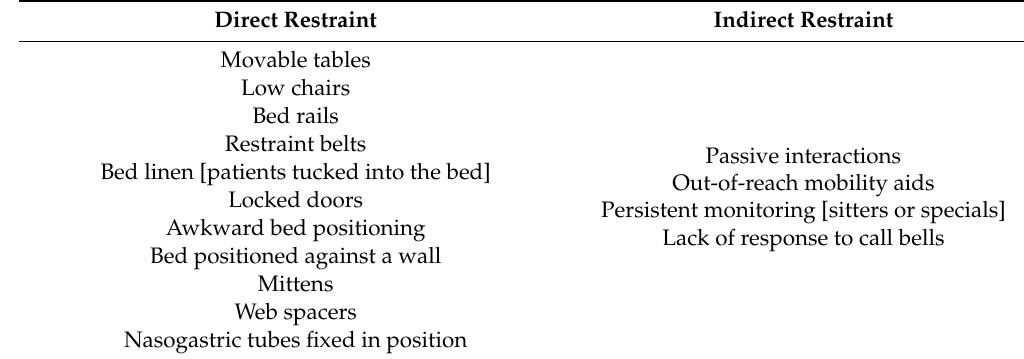
Table 1. Examples of direct and indirect restraint used in clinical